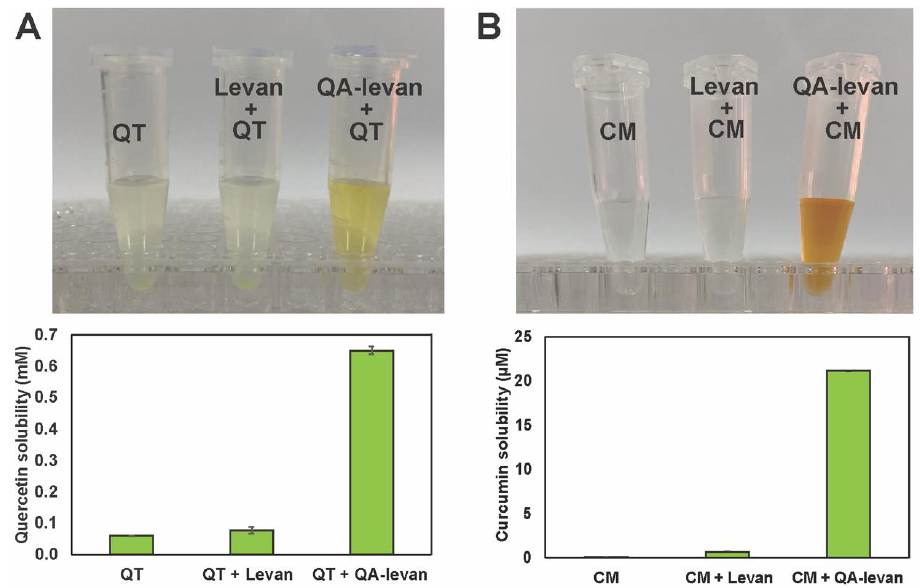
Figure 5. Water solubility of ( A ) quercetin (QT) and ( B ) curcumin (CM) complexed with levan and QA-levan.